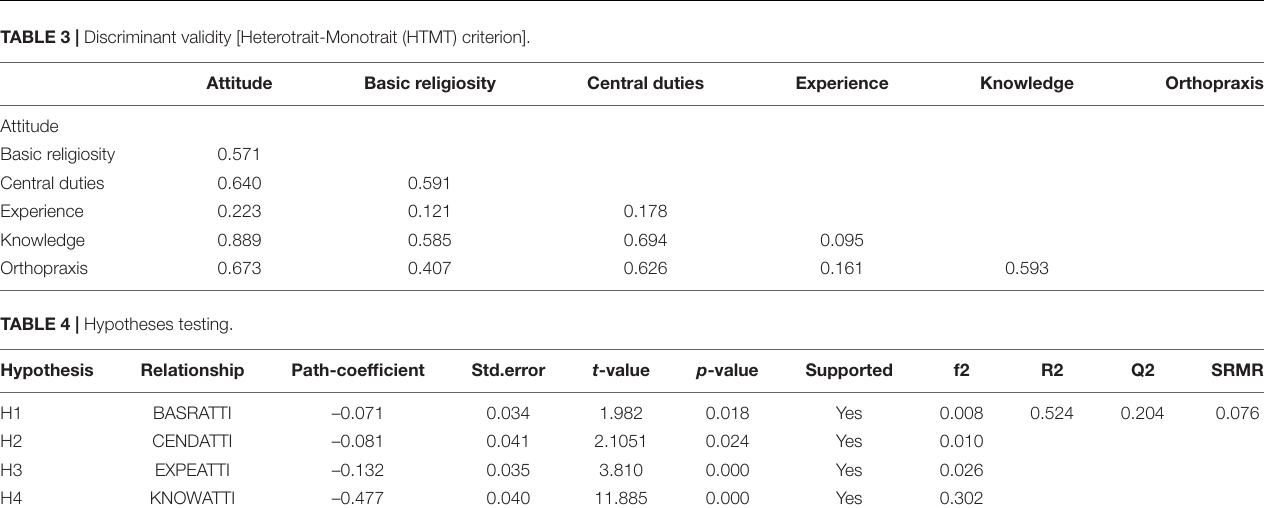
FIGURE 1 | Theoretical framework.